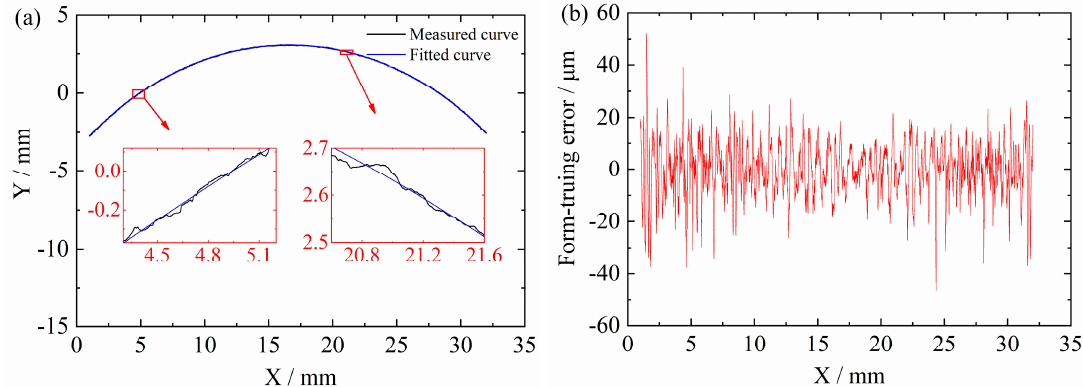
Figure 9. Line-profile of the form-trued spherical diamond wheel: ( a ) measurement results and data fitting, ( b ) 2D from-truing error.